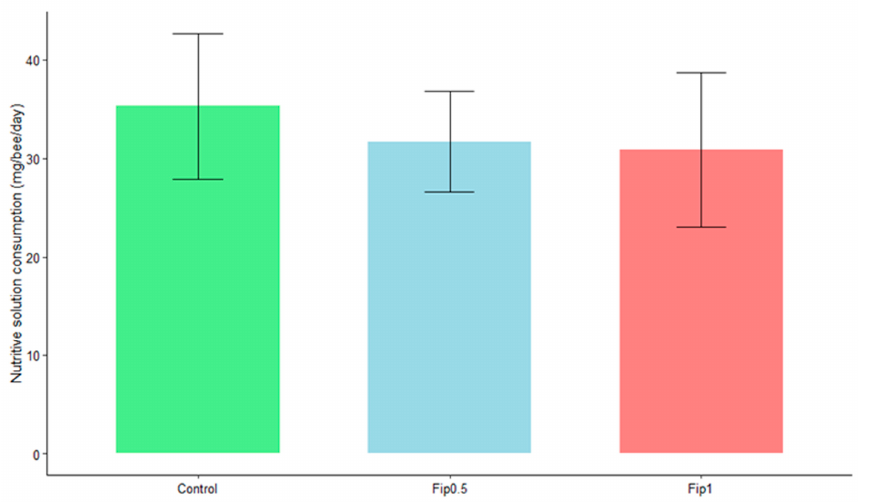
Figure 2. Average daily consumption by bees of a 50% sucrose solution under different conditions. Statistical analysis with Student’s t-test did not show a significant effect of fipronil on daily sugar consumption between the different conditions ( p -value ˃ 0.05).